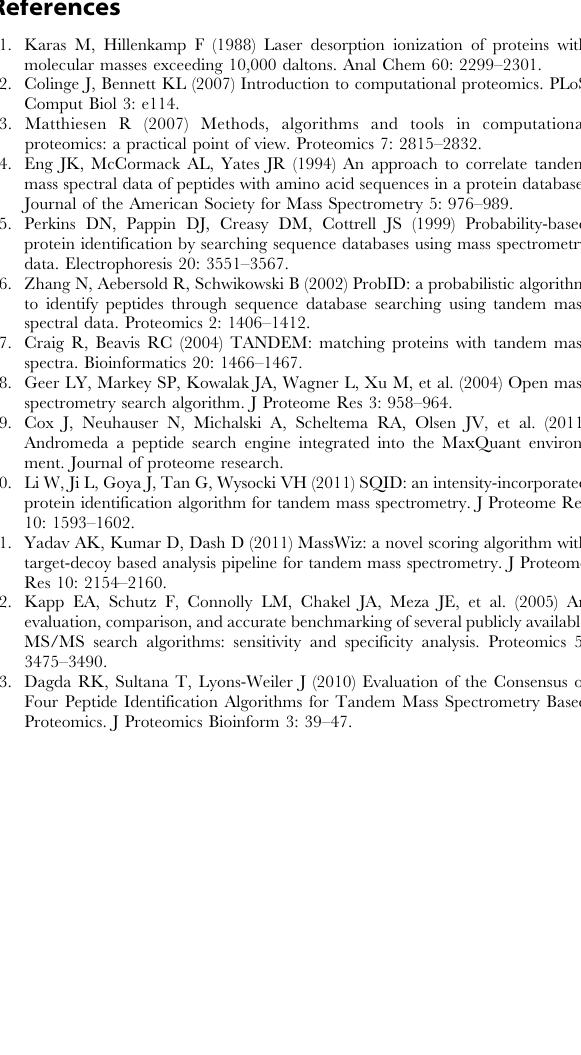
Figure S1 The selected peaks and the peptide matching number of each peak. Table S1 Number of the same peptides identified between any two algorithms of Mascot, Sequest and Dispec.